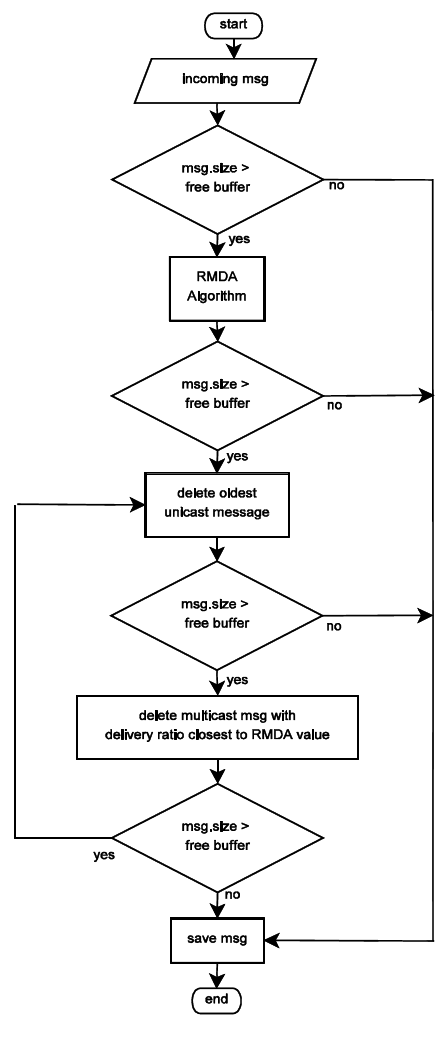
Figure 9. The buffer management strategy in RMDA Figure 9 . The buffer management strategy in RMDA [48].